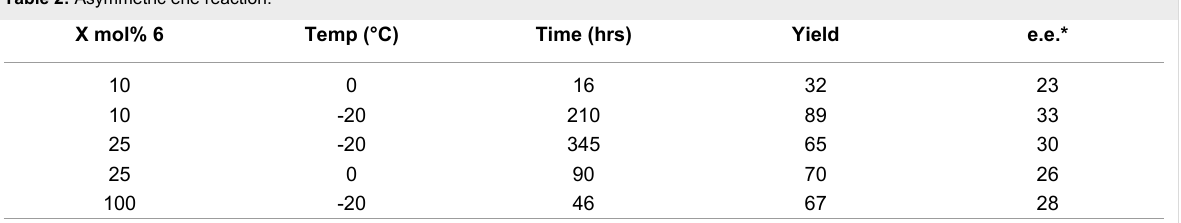
Table 2: Asymmetric ene reaction. X mol% 6